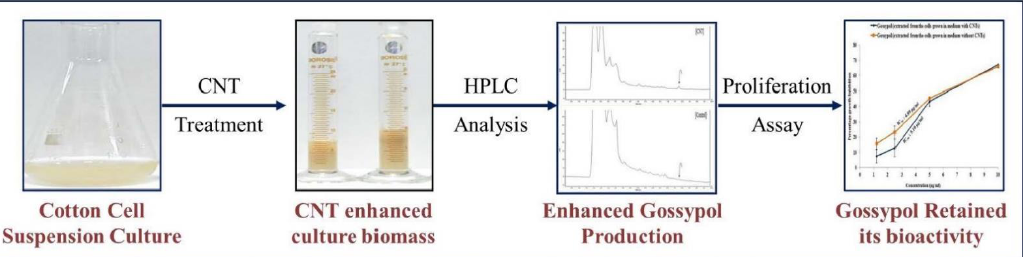
Figure 5. Schematic representation of CNT-induced gossypol production in cotton cell suspension culture.